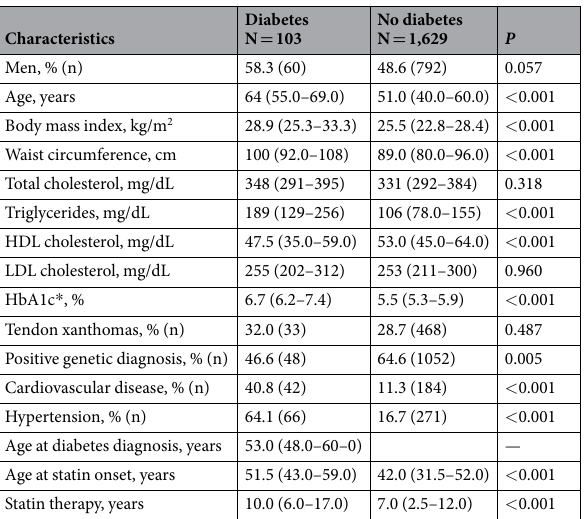
Table 2. Demographic and clinical characteristics of heterozygous familial hypercholesterolemia patients with or without diabetes. * Values refer to 87 (84.5%) diabetics and 410 (25.2%)